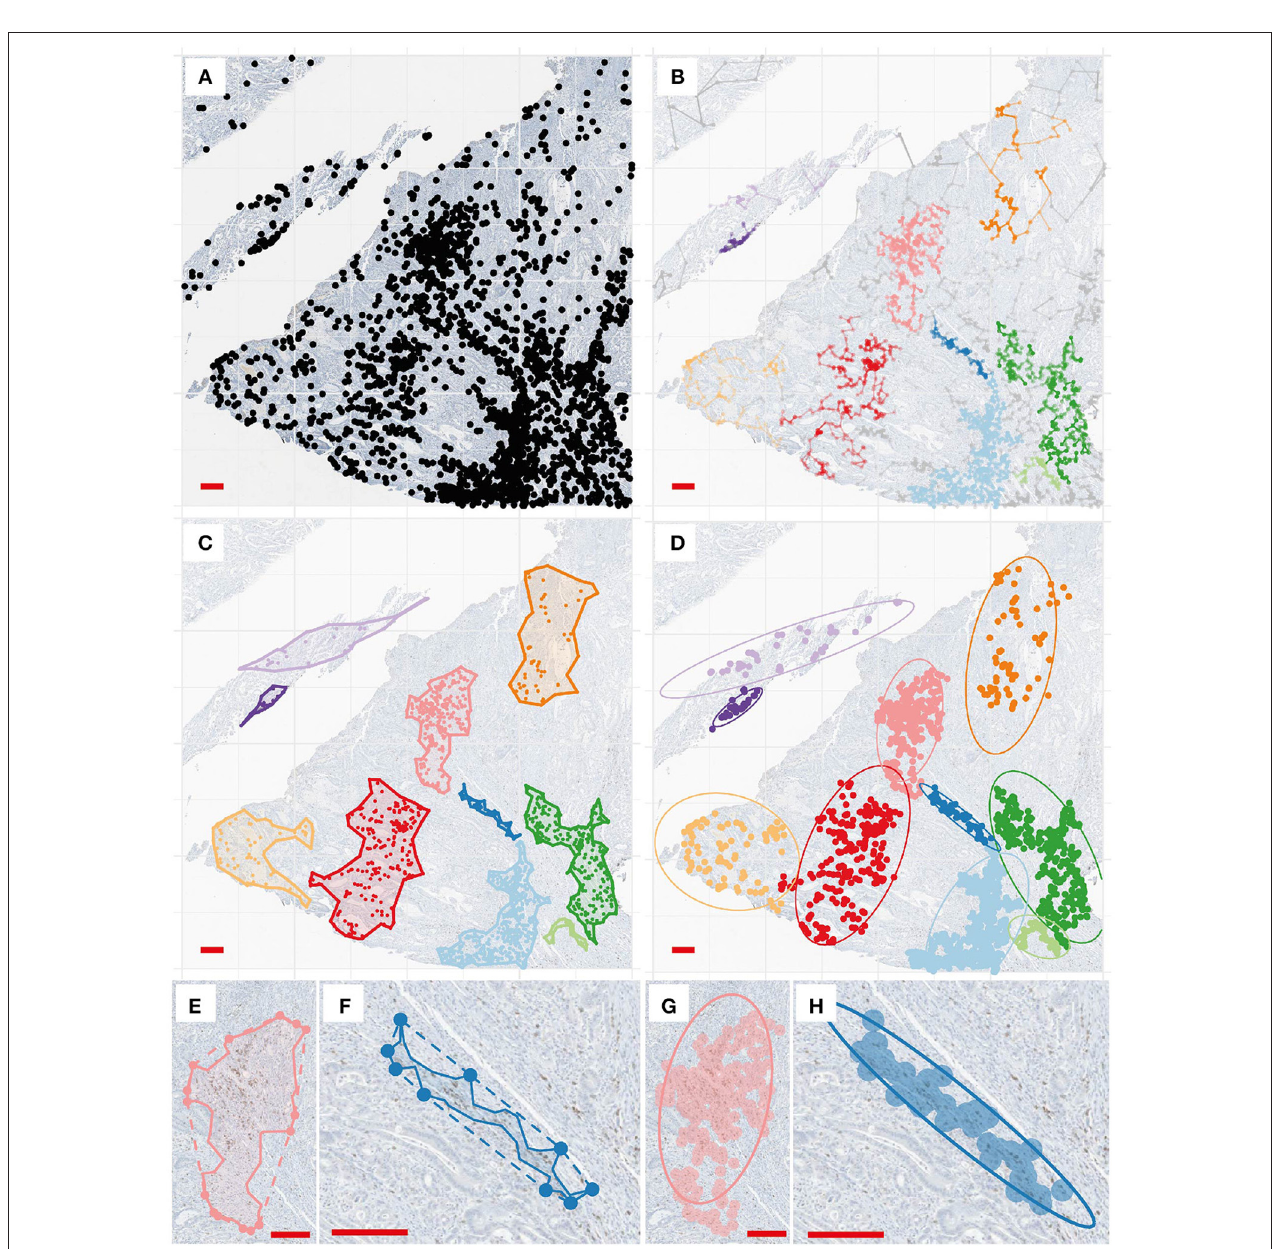
FIGURE 5 | Cluster analysis and shape descriptors. (A) Point pattern of a region for illustration. (B) Clustering results. Each color correspond to a detected cell cluster. (C) For each cluster, we determined the alpha-shape (concave outline). (D) For each cluster, ellipse fitting is performed at a 95% level. (E,F) . Convex hull (dashed line) and concave shapes of two selected clusters. Convexity is calculated to be 0.76 and 0.41, and circularity is calculated to be 0.42 and 0.12, respectively. (G,H) . Ellipse fitting for the same clusters. Eccentricity is calculated to be 0.88 and 0.99.